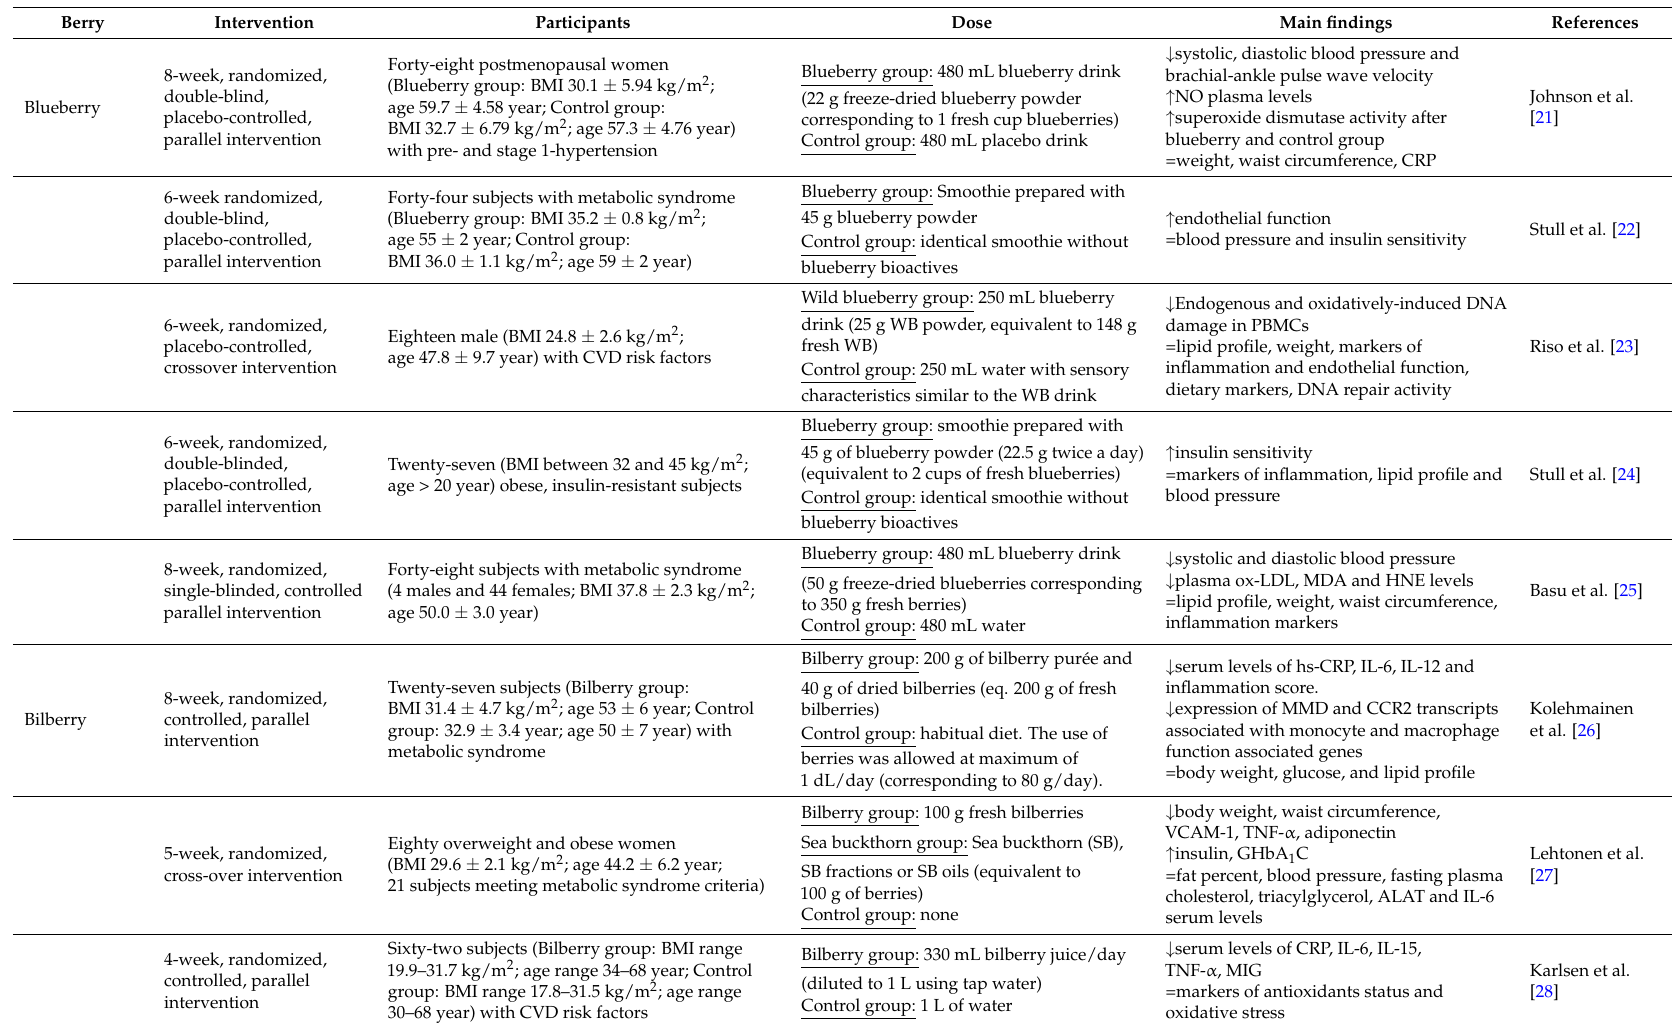
Table 1. Effect of berry consumption on Metabolic Syndrome and associated risk